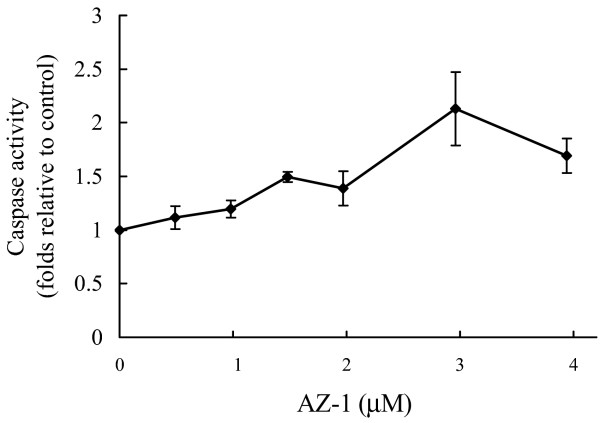
The enzyme activity of caspase 3 in BC-M1 cells was induced by bis-aziridinylnapthoquinone (AZ-1). Cells were seeded for 24 hours before the addition of AZ-1 in various concentrations. The cell lysate was prepared for analysis by a CPP32/caspase 3 colorimetric assay kit according to the manufacturer's instructions. The enzyme activity is shown as the fold increase relative to the control.